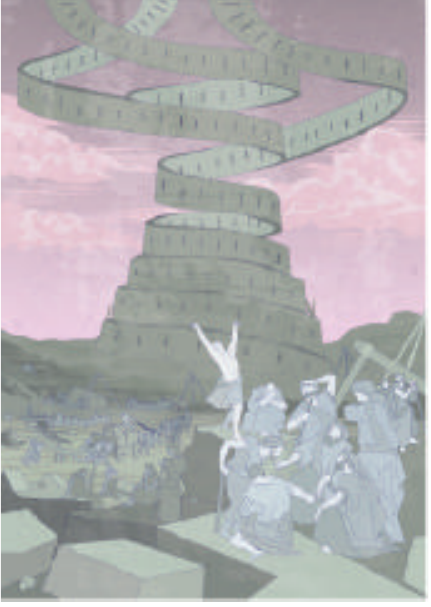
Figure 3: The “Confusion of Tongues,” an engraving by Gustave Dor´e (1832–1883), was modified by D. Caetano-Anoll´es to portray the event of diversification that halted the construction of the Tower of Babel. In linguistics, the biblical story inspired tree thinking. We take the metaphor as the fall of the urancestor of cellular life and the replacement of “ scala naturae ” by branching processes of